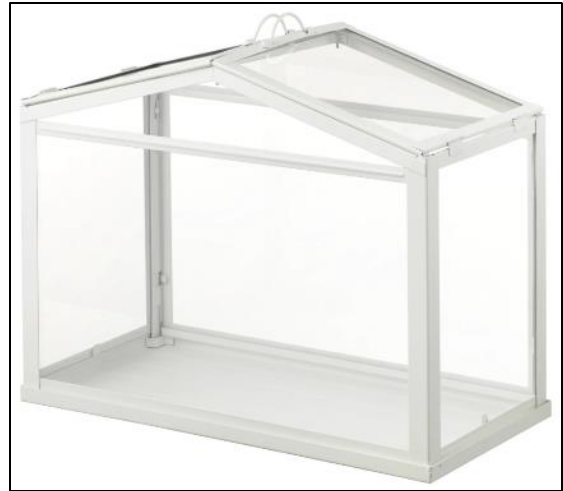
Figure 1. Enclosed Glass Terrarium.